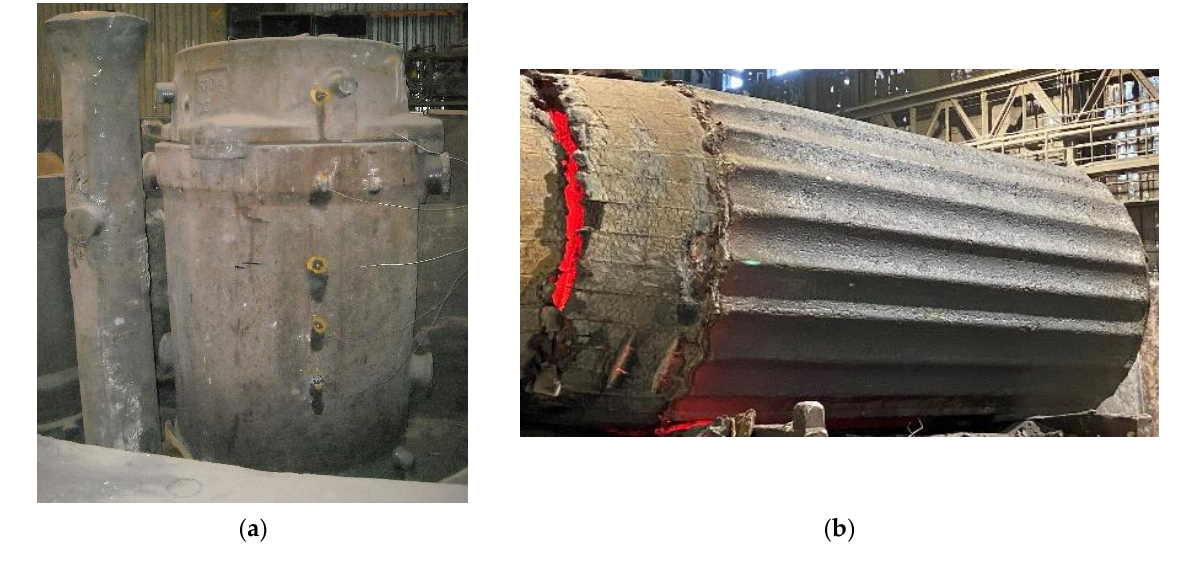
Figure 1. Industrial casting system and ingot: ( a ) 40 MT ingot bottom pour casting system; ( b ) 40 MT steel ingot after demolding.